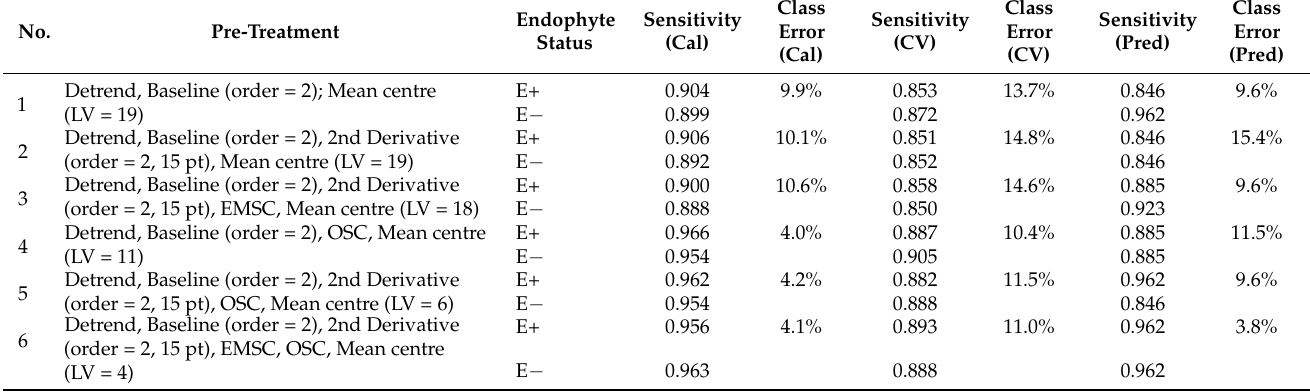
Table 2. Pre-treatment method optimization for PLS-DA classification models using full spectra for E+ ( n = 551) and E − ( n = 454) calibration dataset and E+ ( n = 26) and E − ( n = 26) prediction